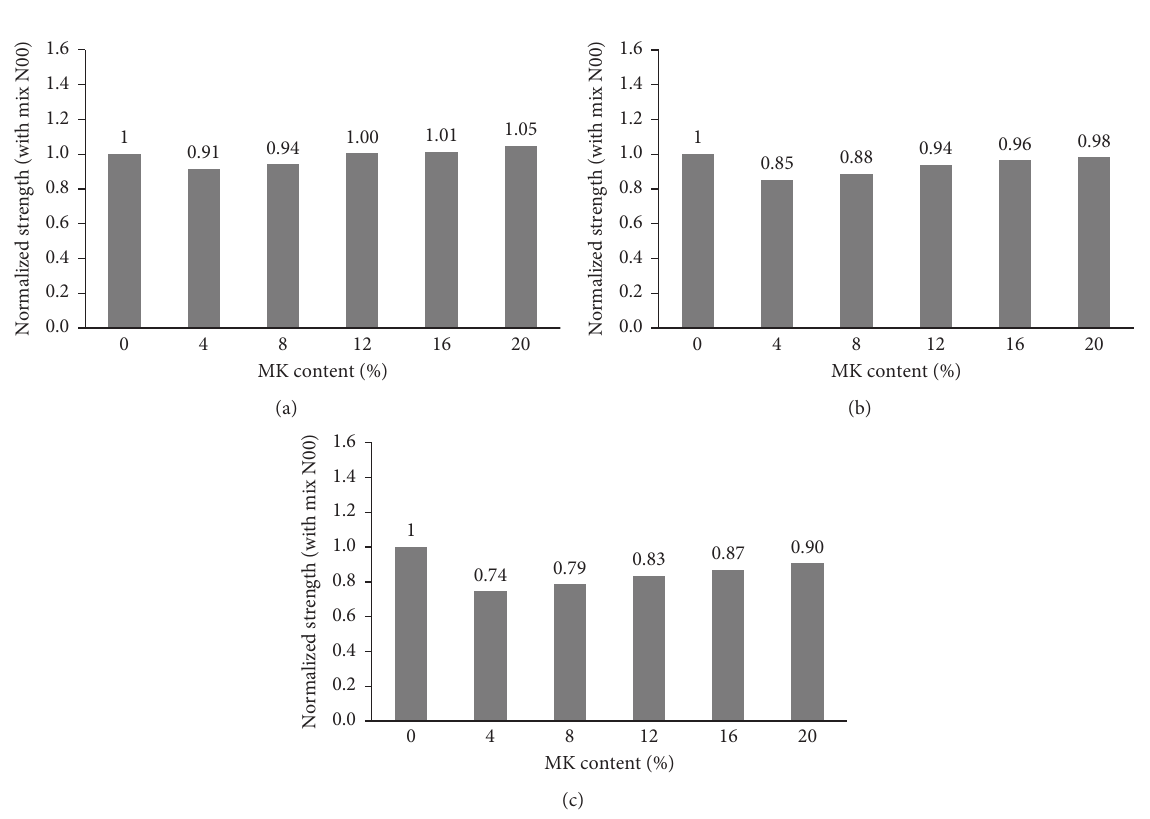
Figure 9: Normalized strength (with mix N00) for mixes. (a) RCA � 35%. (b) RCA � 70%. (c) RCA �